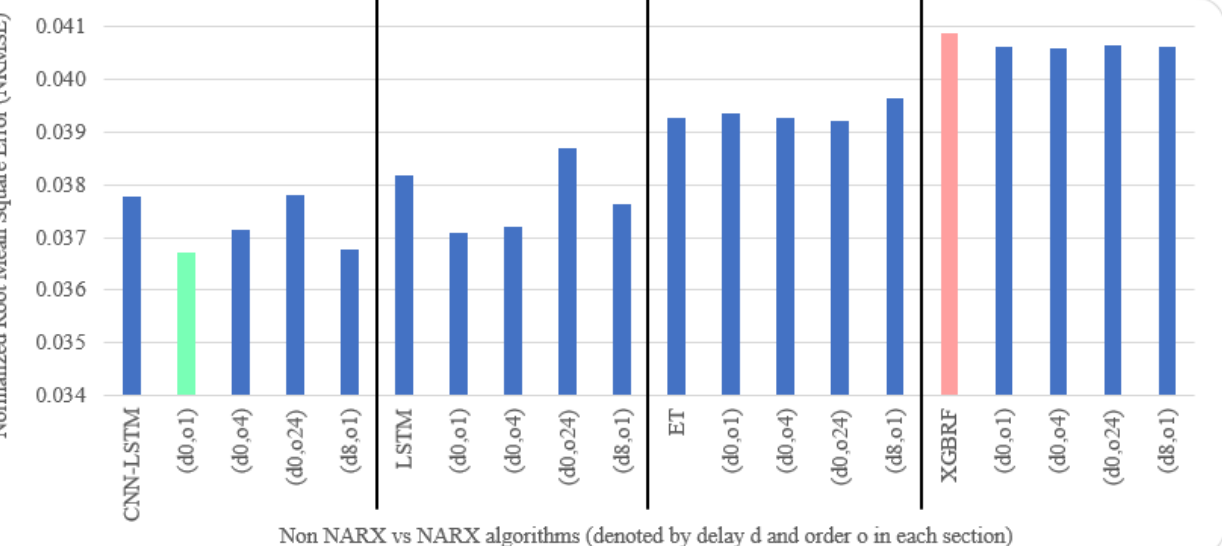
Figure 26. Evaluation results of non-NARX and NARX in terms of offline training time for the Bei- jing dataset.